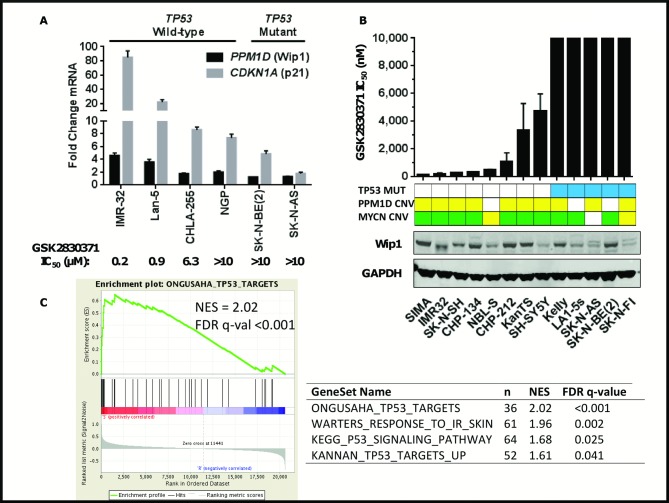
Neuroblastoma cell lines with wild-type TP53 and functional p53 response are sensitive to GSK2830371.
A, As a measure of p53 functional response, six neuroblastoma cell lines with different sensitivities to GSK2830371 (indicated by IC50 value in a proliferation assay) and TP53 mutational status were exposed to ionizing radiation and allowed to recover for 1 hour, after which RT-PCR was carried out to measure changes in PPM1D and P21 transcript levels. Data represent fold change relative to untreated cells (mean ± SD). B, Anti-proliferative effect of GSK2830371 in a seven day cell proliferation assay. Data represent mean ± SD. Copy number for PPM1D and MYCN is represented as green for gain of >6 copies; yellow for 2–6 copies. WIP1 protein level was determined by western blotting of whole cell lysates from a panel of neuroblastoma cell lines. C. GSEA enrichment plot showing a TP53 gene signature that is significantly enriched in the sensitive group (S) relative to the resistant group (R) of neuroblastoma cell lines (see Table 1). Additional TP53 genesets tested by GSEA and their respective numbers of genes (n), normalized enrichment scores (NES) and FDR q values are shown.